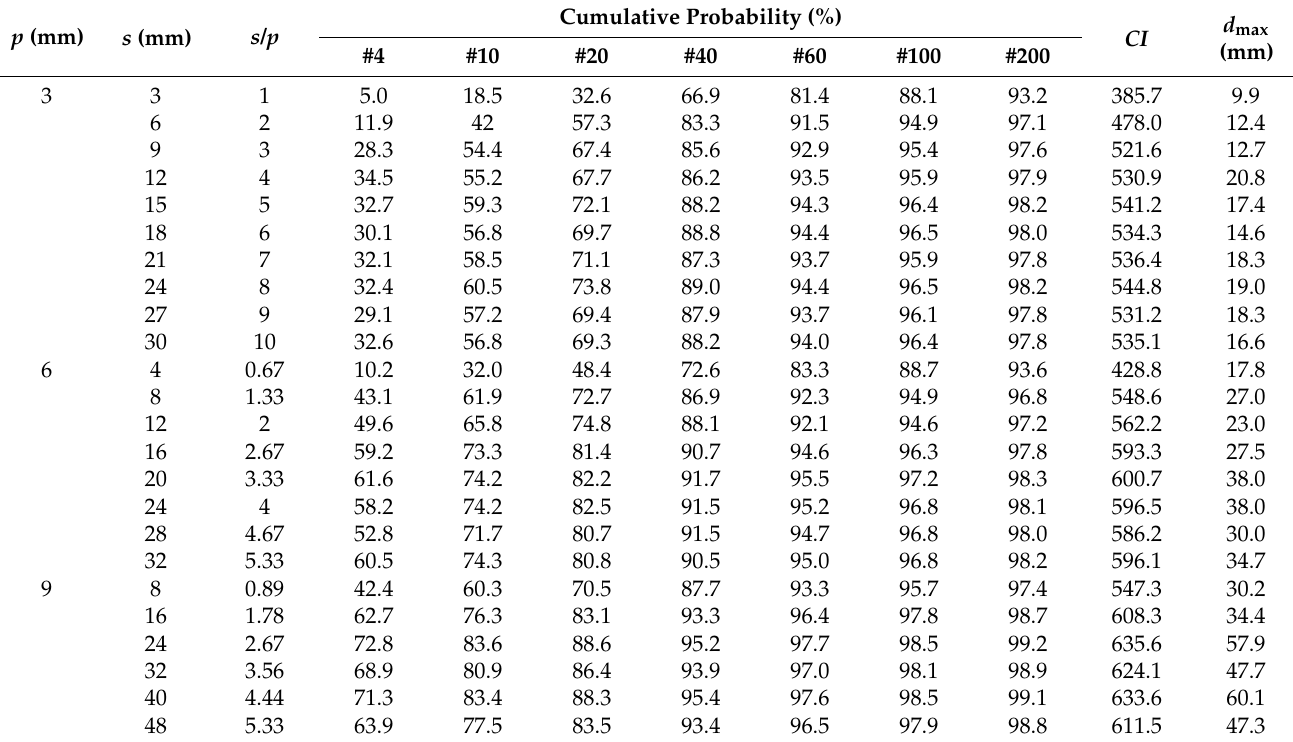
Table 4. Chip size distribution and maximum diameter for model rock of UCS 30 MPa.